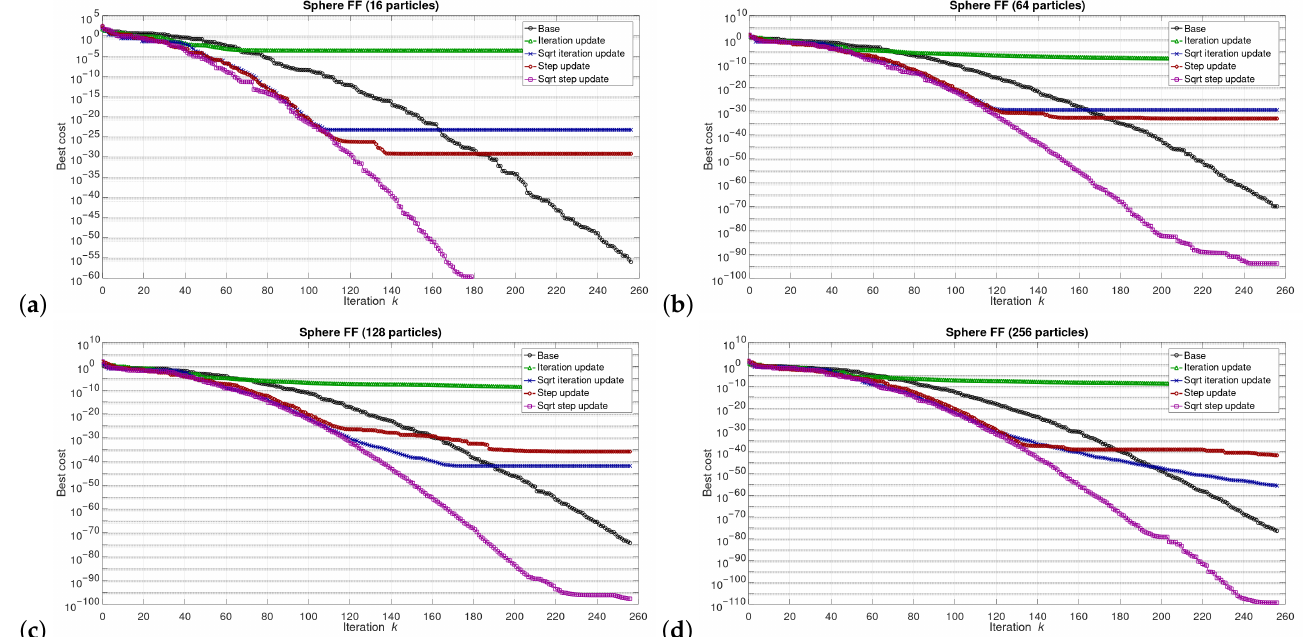
Figure 10. Selected results for Sphere FF for ( a ) 16, ( b ) 64, ( c ) 128, and ( d ) 256 particles.